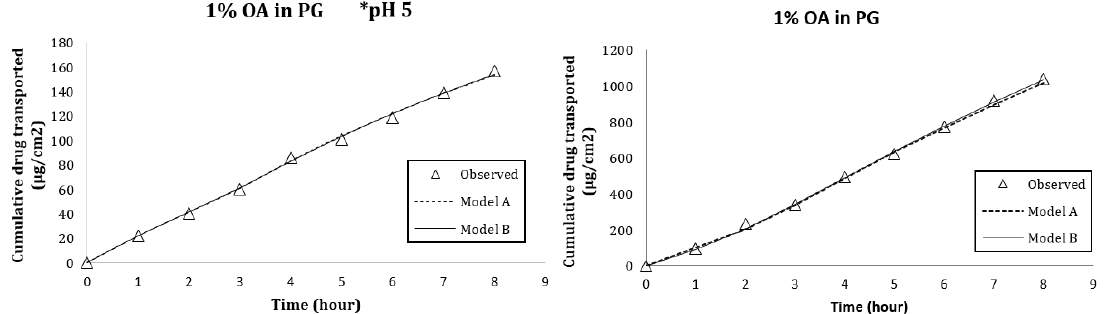
Figure 3. Typical example of fitting data of domperidone using 1% OA (oleic acid) in PG (propylene glycol) using Model A (---) and Model B (—) for pH of 5 and pH of 1.